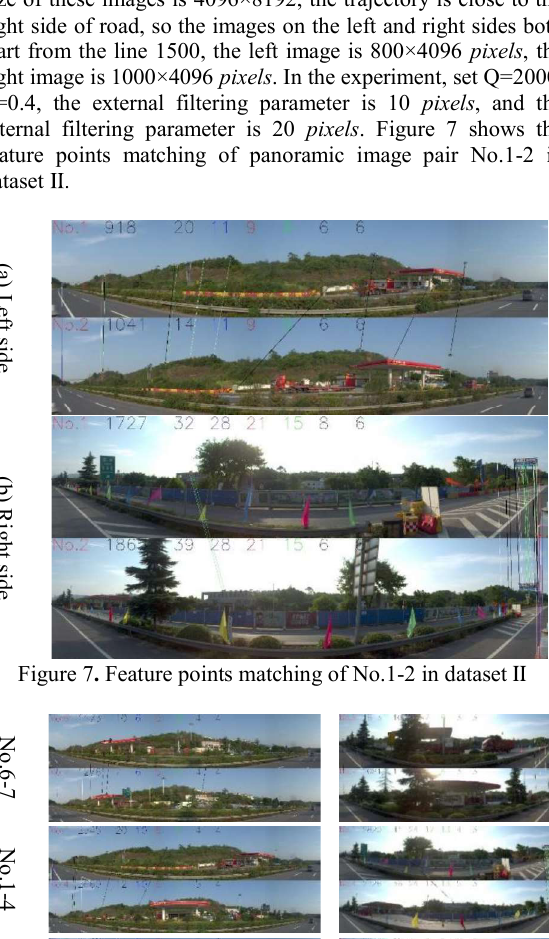
the left and right sides in No.1-5, but 2 and 0 points in No.1-10, which doesn't meet the number requirement, so the feature points after coincidence matching are directly used in No.1-10.